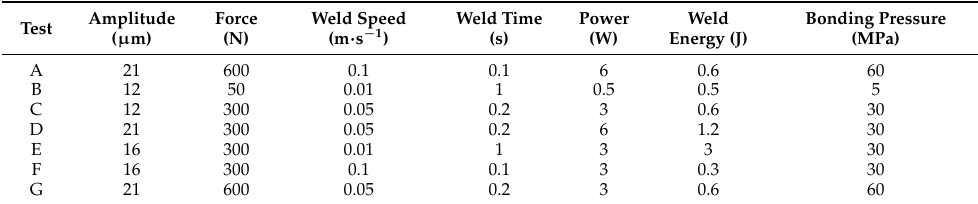
Table 2. DOE of bonding parameters used for coating the PcBN